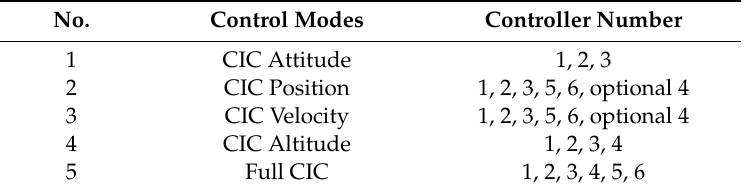
Table 2. Available control modes implemented in autopilot